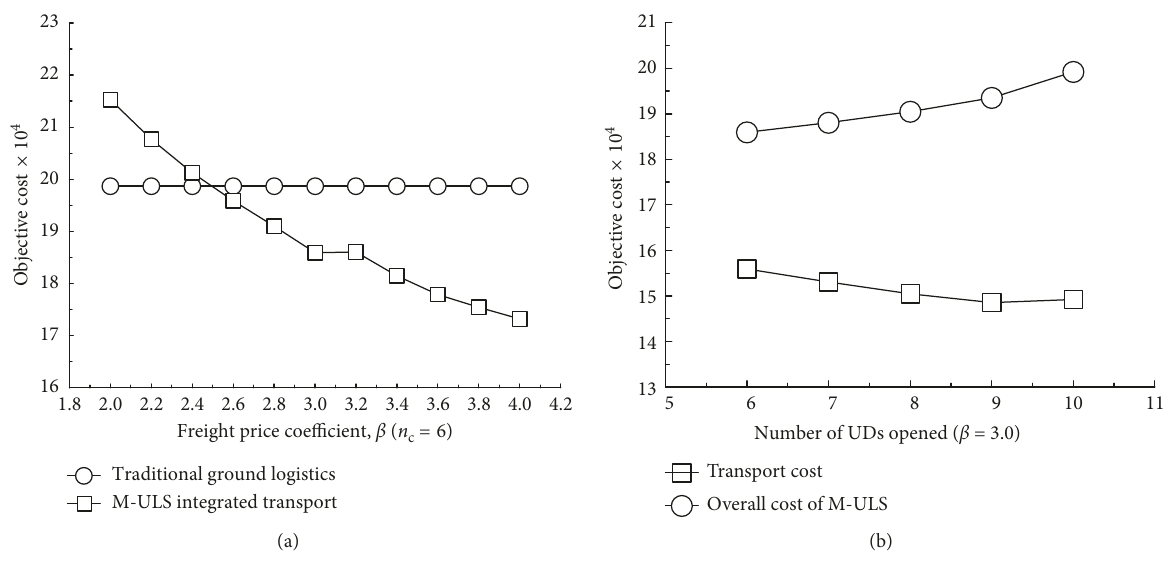
Figure 7: Variation of objective cost against the change of β and n